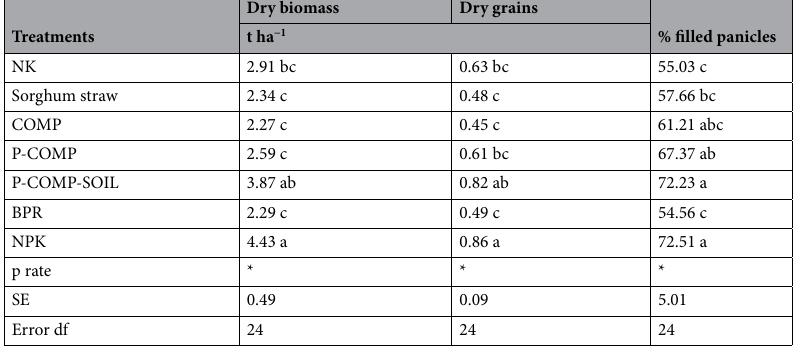
Table 1. Effect of organic and organo-mineral amendments on sorghum growth properties following one-way Analysis of Variance (ANOVA). Within the same column, values assigned with the same letter are not significantly different according to the Student–Newman–Keuls (SNK) test at the 5% probability level. Parameter values assigned to different letters differ significantly (*) at p < 0.05. NK Without phosphate or compost addition, COMP Sorghum straw-based compost, P-COMP Sorghum straw-based compost + BPR, P-COMP-SOIL Compost made from sorghum straw, BPR, and sorghum rhizosphere soil, BPR Burkina phosphate rock, filled ears Ears filled with grains (the percentage is calculated based on the total number of ears found in a harvest area and the number of ears filled with grain), SE Standard error, Error df Error degree of